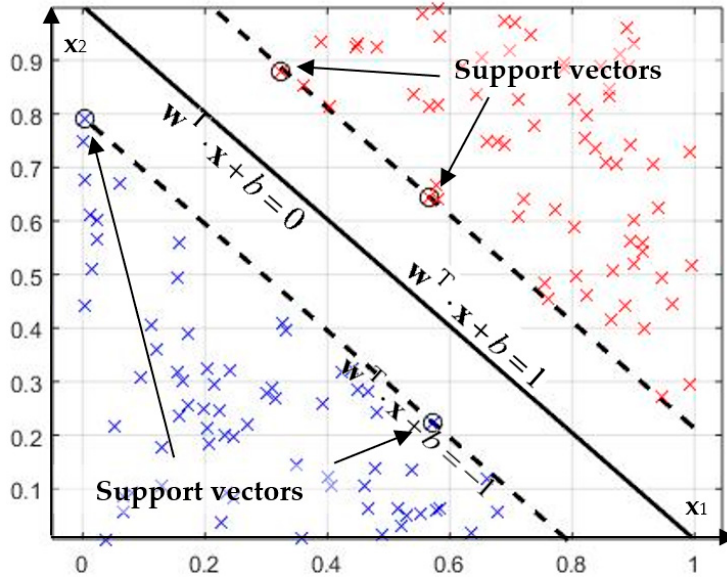
Figure 11. Dividing border in two-dimensional space. However, in most practical cases, the training sample is not linearly separable, that is, there is not a single hyperplane that satisfies the system of inequalities (11). In order for the SVM algorithm to be applied in this case, it must be modified and allow some misclassification of the training sample objects. A penalty is introduced for the total classification error, and the optimization problem takes the form: